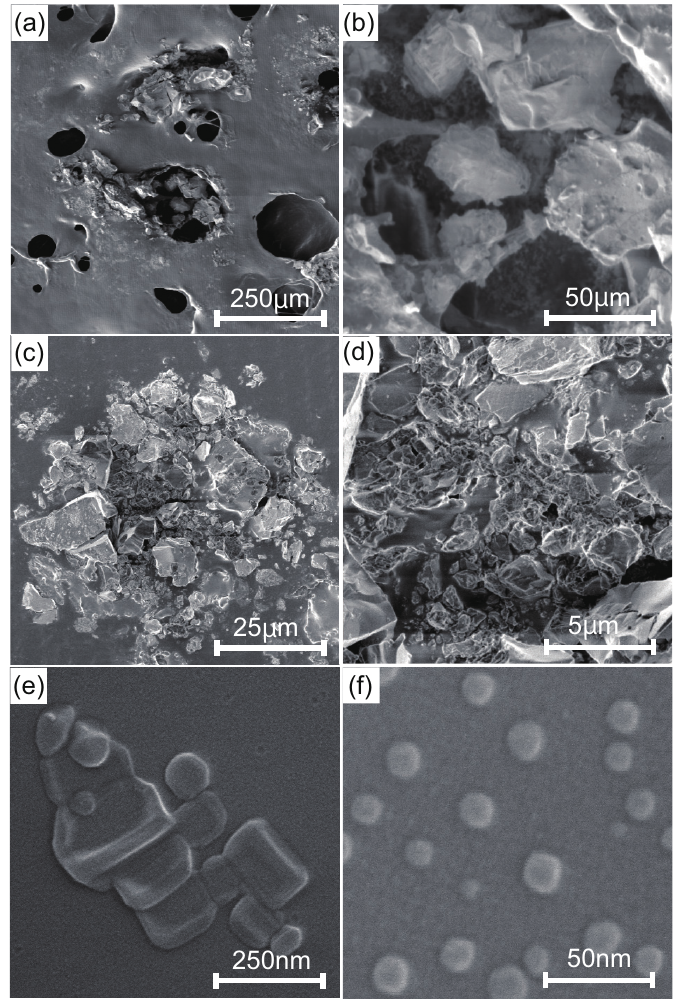
Figure 1. FE-SEM images of IFMC [19]: ( a ) × 100 at 1 kV, ( b ) × 500 at 1 kV, ( c ) × 1000 at 1 kV, ( d ) × 5000 at 1 kV, ( e ) × 100,000 at 10 kV, and ( f ) × 200,000 at 10 kV. Reprinted from Reference [19]. The subjects of this research included eight male and ten female students who belong to athletic clubs at Fukushima University, Japan. Table 1 shows the age and physical characteristics of each subject. The objectives, methods, and safety of this study were fully explained to subjects in advance, and informed consent was obtained from each